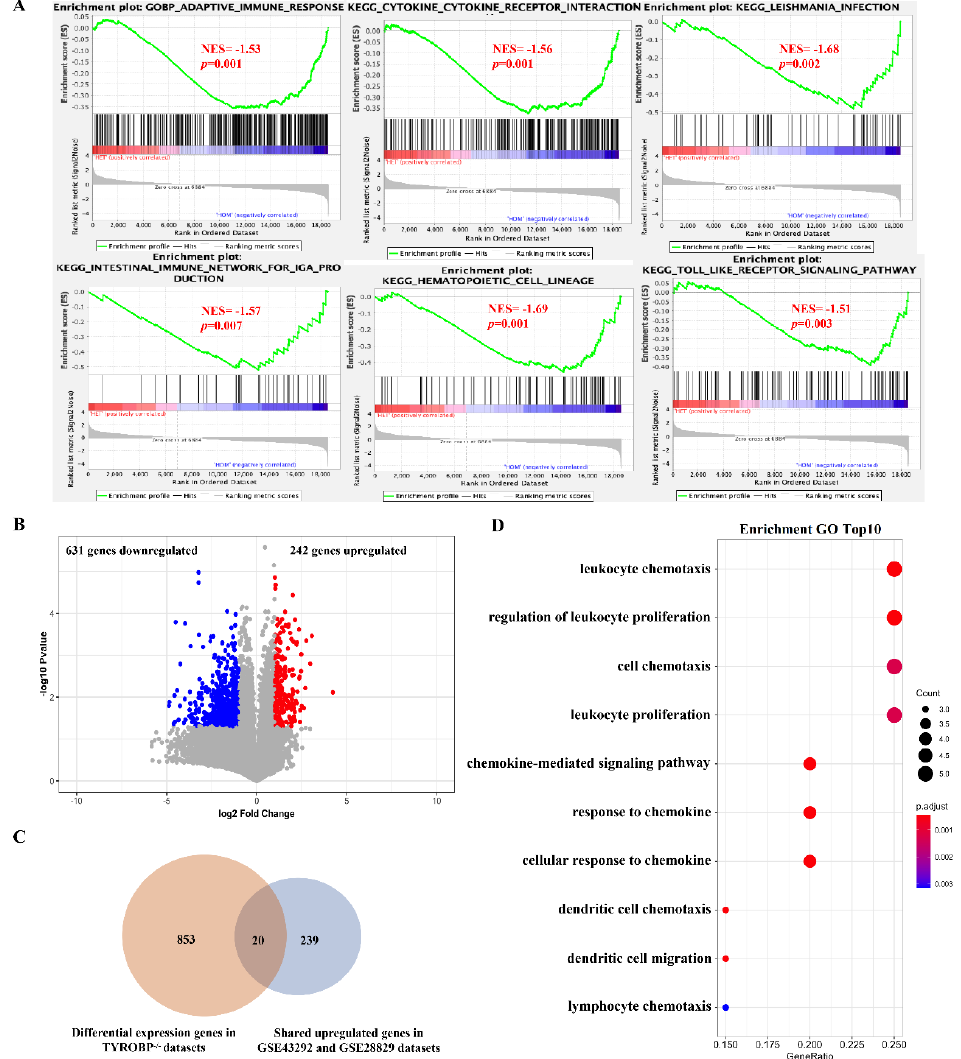
Figure 7. Validation of TYROBP key gene using gene expression profile of TYROBP +/ − and TYROBP −/− mouse brain tissue. ( A ) GSEA analysis showed gene sets in TYROBP − / − samples were significantly enriched. ( B ) Volcano diagram of the differentially expressed genes comparing samples from TYROBP +/ − and TYROBP −/− mouse brain tissue. ( C ) Venn diagrams showing common genes between DEGs and commonly upregulated genes in GSE43292 and GSE28829 datasets. ( D ) The bubble diagram of GO - BP enrichment analyses of 20 common genes. Dot sizes represent counts of enriched common genes, and dot colors represent adjusted p - value.